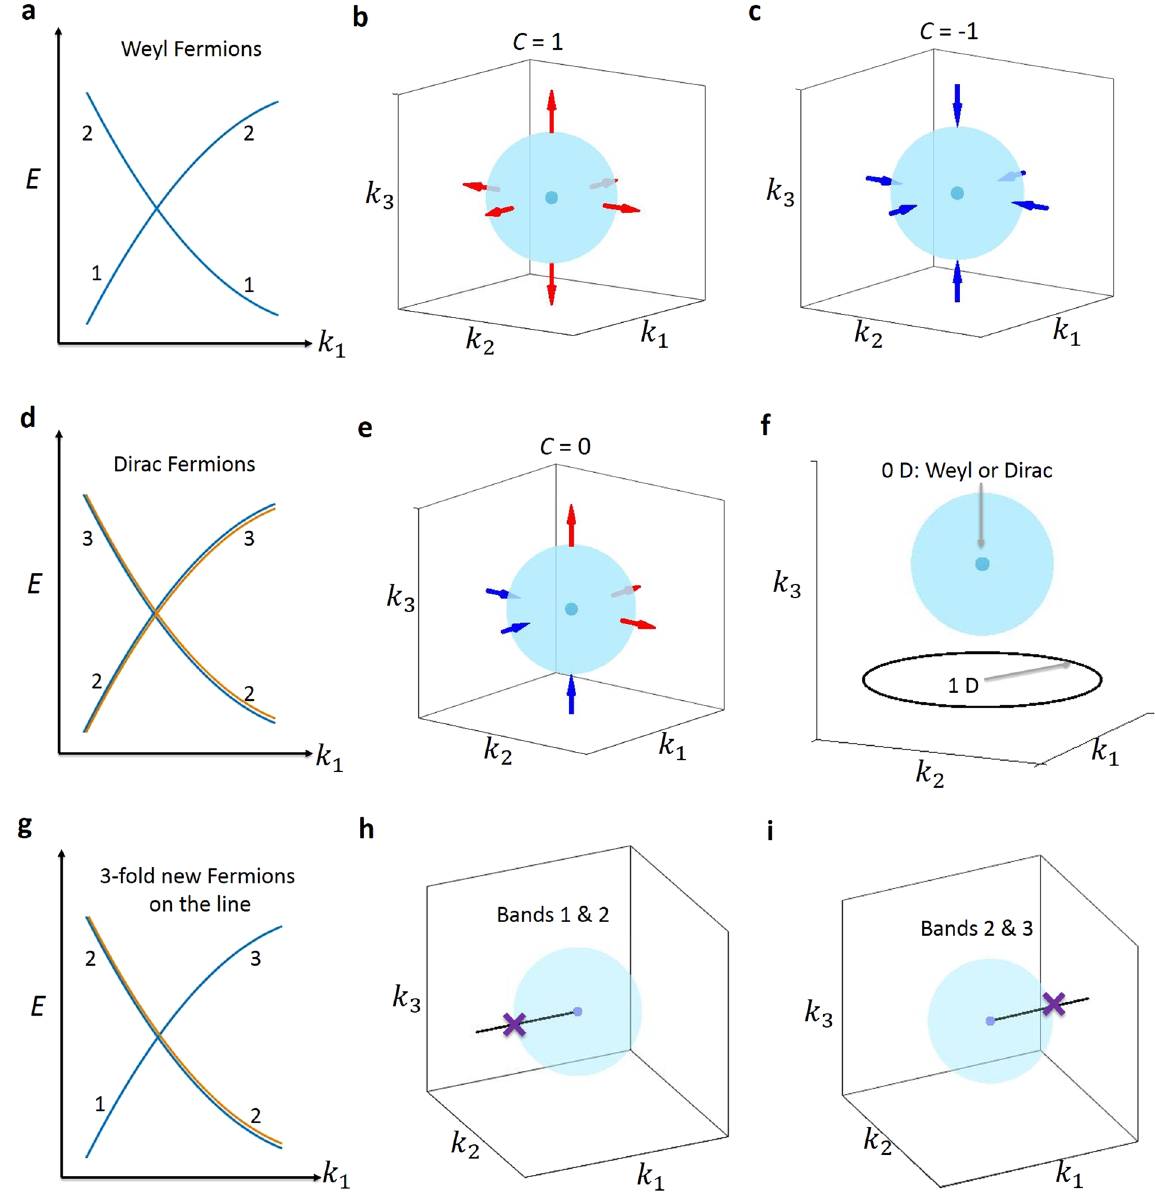
Figure 2. Comparison between Weyl, Dirac, and nexus band crossings. ( a ) A Weyl node arises from the crossing between two singly degenerate bands. The valence and conduction bands are noted as “1” and “2”. ( b , c ) We enclose the Weyl node by a sphere in k space. We notice that the sphere satisfies following two crucial conditions: (1) The sphere is a 2D closed manifold; (2) Bands 1 and 2 are separated by a band gap at all k points on the sphere. These two facts guarantee that one can calculate the Chern number of the filled valence bands on this sphere. Because the Weyl nodes are Berry curvature monopoles, it has been shown 1 the Chern number (C) of the sphere equals the chiral charge ( χ ) of the enclosed Weyl node, which serves as the topological invariant of the Weyl node. ( d , e ) A Dirac node arises from the crossing between two doubly degenerate bands (1, 2 and 3, 4). We can also enclose the Dirac node by a sphere in k space. The sphere will also satisfy the same two conditions. Because a Dirac node can be viewed as two degenerate Weyl nodes of opposite chirality, it can be shown that the chiral charge of a Dirac node is always zero, i.e., χ = 0. ( g–i ) The new band crossing here arises from the crossing between a singly degenerate band and a doubly degenerate band. However, if we try to enclose the triply degenerate node with a sphere, we see that it is not possible to have a fully gapped band structure on the sphere. Specifically, between bands 1 and 2, the band gap vanishes at the left-pole of the sphere. Similarly, between bands 2 and 3, the band gap is zero at the right-pole of the sphere. For this reason, it is not possible to define and calculate the Chern number on the sphere as done in the Dirac/Weyl cases. ( f ) A trivial case where the band crossing is a simple composition of a 0D Weyl node plus a 1D nodal